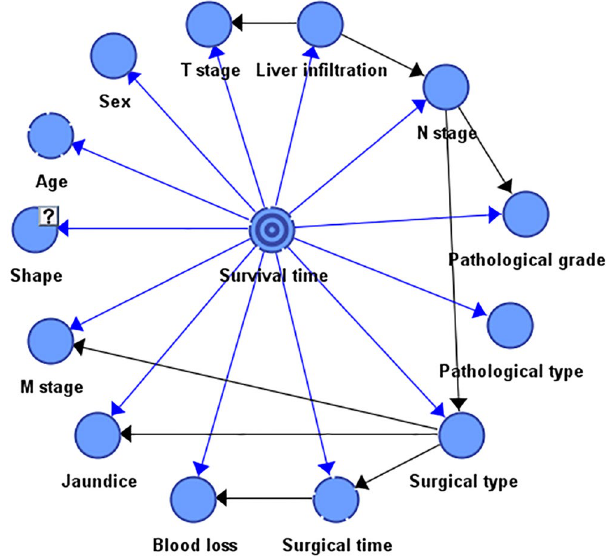
Figure 3. Bayesian network model for prognostic